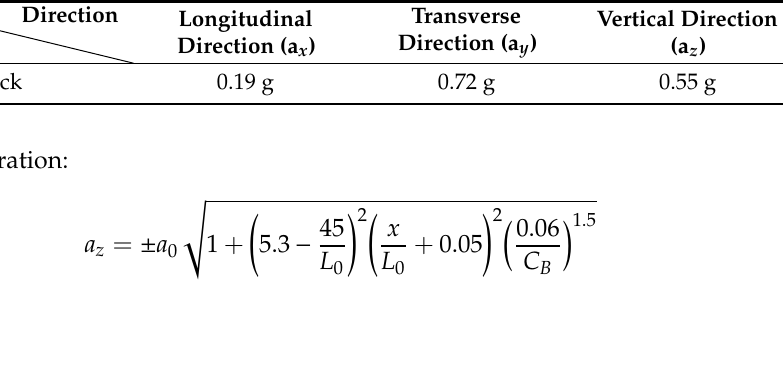
Table 4. Acceleration of ship